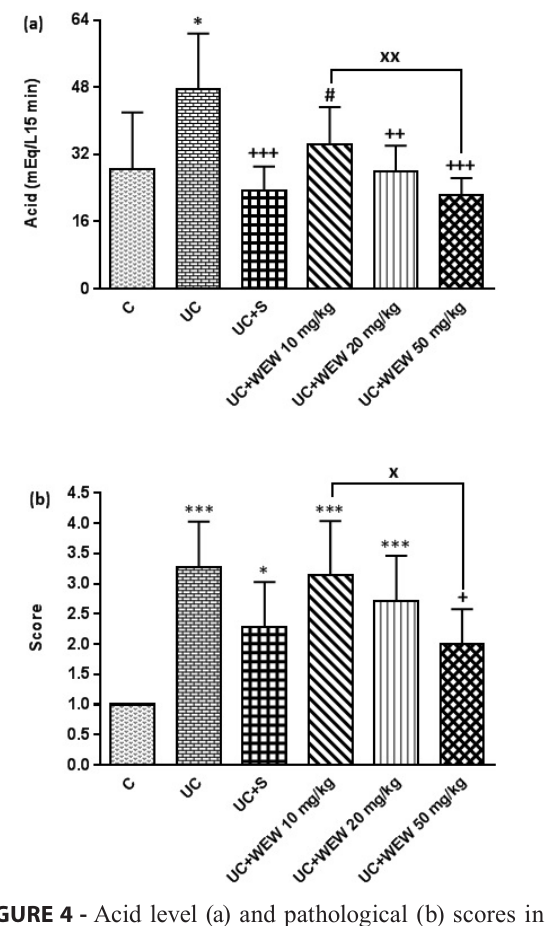
FIGURE 4 - Acid level (a) and pathological (b) scores in the colon tissue of control (C), ulcerative colitis group (UC), ulcerative colitis rats treated with sulfasalazine (UC+S) and woody endocarpium of wulnut extract (UC+WEW), (n=7 in each group). Data are presented as mean ± SEM values. * p<0.05 and *** p<0.001 shows significant differences compared to group C. + p<0.05, ++ p<0.01 and +++ p<0.001 show significant differences compared to group UC. # p<0.05 shows significant differences compared to group UC+S. x p<0.05 and xx p<0.01 show significant differences between the three concentrations WEW. Statistical analyses were performed using ANOVA with Tukey-Kramer’s